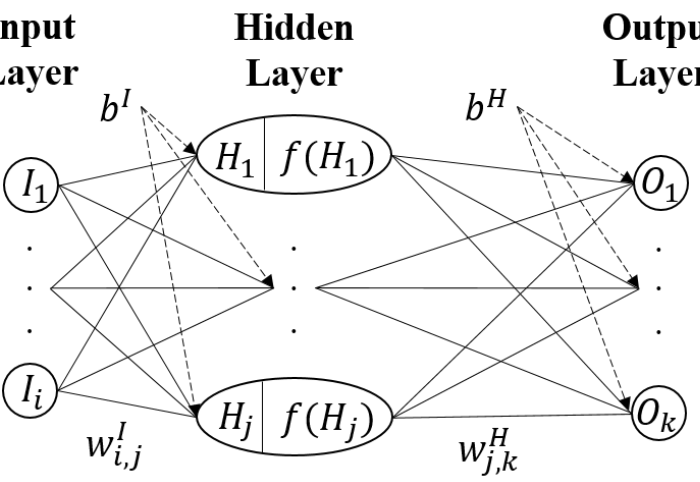
Figure 2. General artificial neural network model.